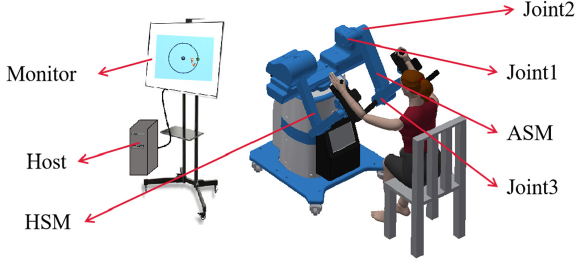
Figure 1. The design of the EBULRR platform.